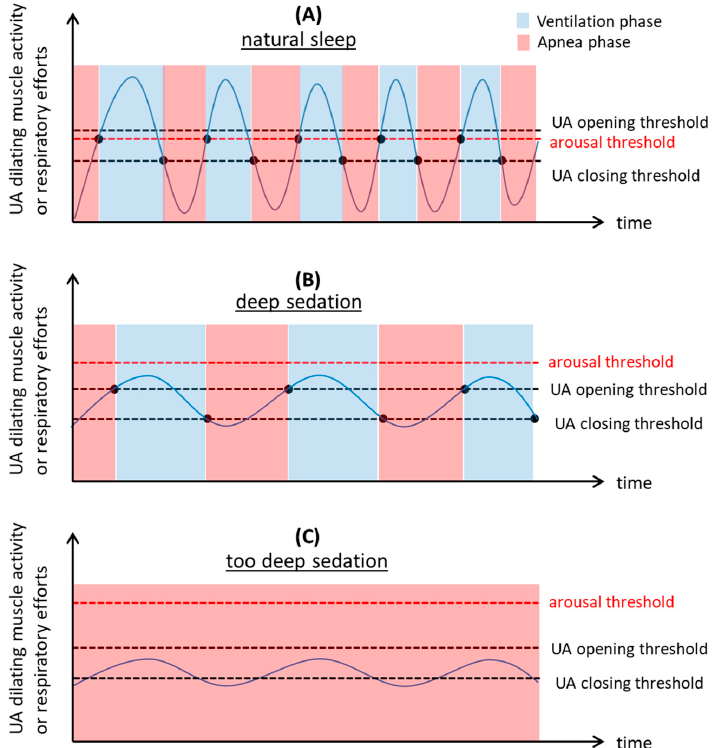
Figure 5. Interactions between the cortical arousal threshold and upper airway (UA) opening and closing thresholds for explaining the mechanisms of periodic obstructive breathing. Sinusoidal curves represent changes of UA dilating muscle activity and respiratory efforts. Intersections (closed circles) between the curves and threshold lines correspond to the timings for the beginning and end of obstructive apneas. ( A ) Interactions commonly seen during natural sleep. When the arousal threshold is below the UA opening threshold, the cortical arousal occurs before airway opening with overshoot increase of the respiratory efforts and UA dilating muscle activity leading to an unstable large ventilatory oscillation. ( B ) Possible interactions during deep sedation. When a sedative increases arousal threshold over the UA opening threshold and decreases respiratory drives to the diaphragm and UA muscles, the UA dilating muscle activity first reaches UA opening threshold restoring ventilation without cortical arousal. The ventilation is maintained until the UA dilating muscle activity decreases below the UA closing threshold which is generally below the UA opening threshold. ( C ) Possible interactions when the sedation is accidentally too deep. Because of profound reduction of the UA dilating muscle activity below the UA opening threshold, UA closure persists possibly leading to prolonged apnea and critical